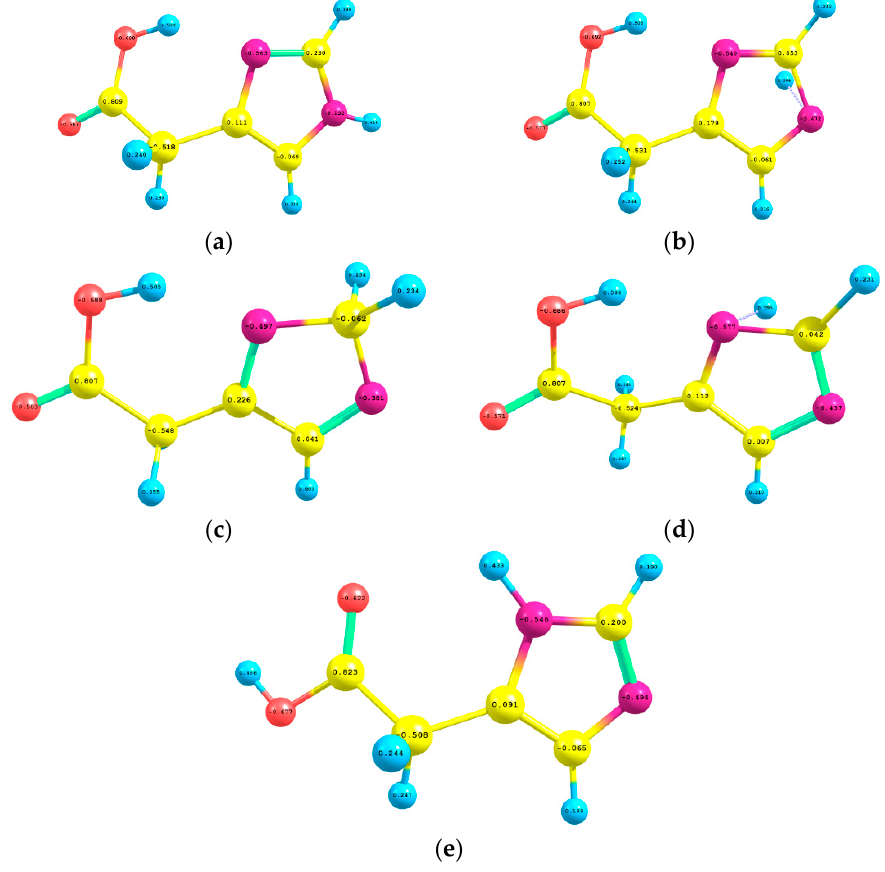
Figure 4. The natural atomic charges of ( a ) (I); ( b ) (TS1); ( c ) INTER; ( d ) TS2; and ( e ) II which were calculated using B3LYP/6-311++G** level of theory.